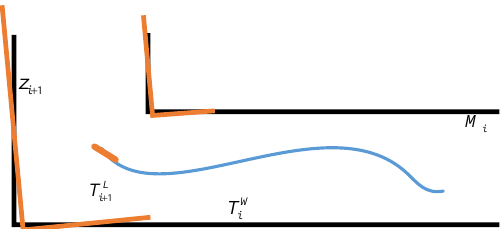
Figure 2. The matching process of the current frame and map.